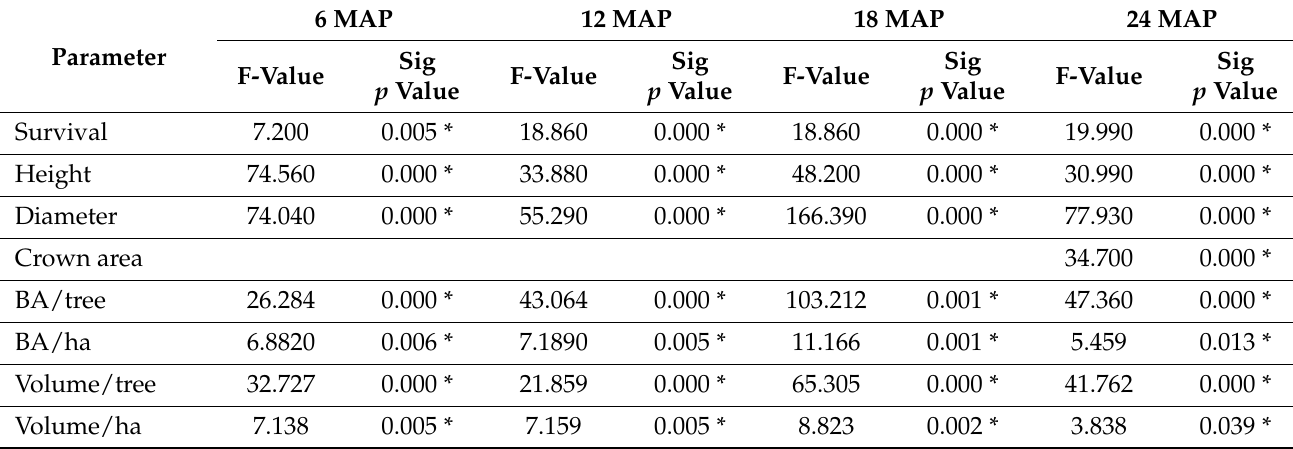
Table 2. Variance analysis on survival rate, height, diameter, basal area, crown area, and volume of the four fast growing tree species at 6 to 24